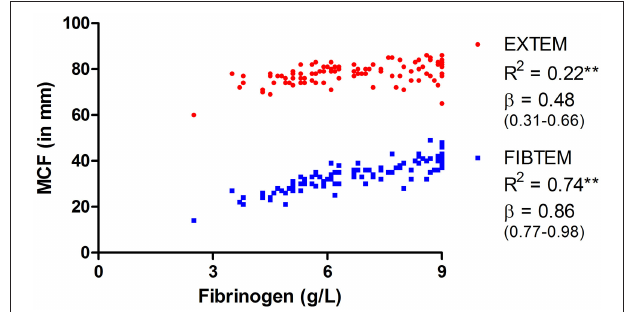
FIGURE 3 | Linear regression between fibrinogen and maximum clot firmness (MCF) of EXTEM and FIBTEM. Presented are R 2 and standardized β coefficient (95% CI). ** p <